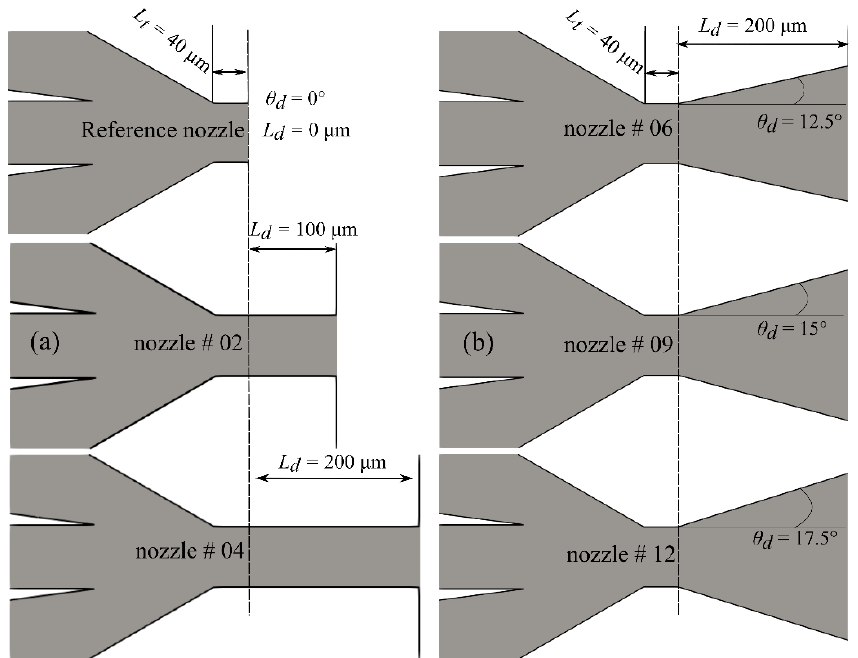
Figure 5. Scheme of the nozzles for 6 selected outlet orifice designs from Table 3: ( a ) zero diverg- ing angle with different extending lengths, ( b ) constant diverging length of 200 µm with varying diverging angles.